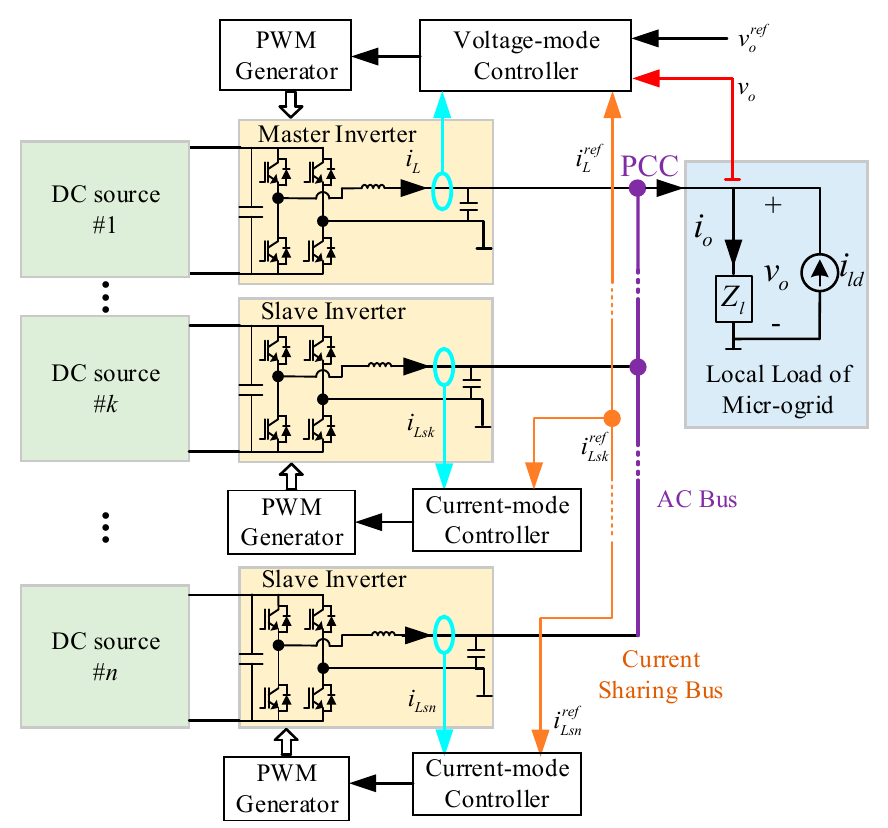
Figure 2. Structures of a parallel-inverter system in the islanded micro-grid with master-slave organization.